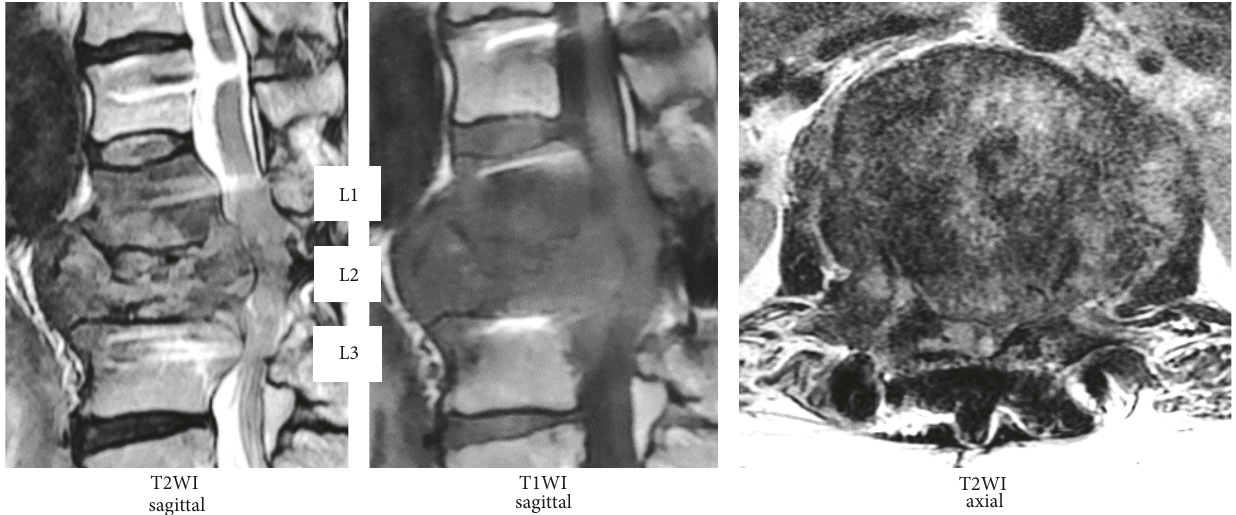
Figure 2: MRI findings. Brightness changes in the L1, L2, and L3 vertebral bodies and compression of the spinal canal by the tumor at the same